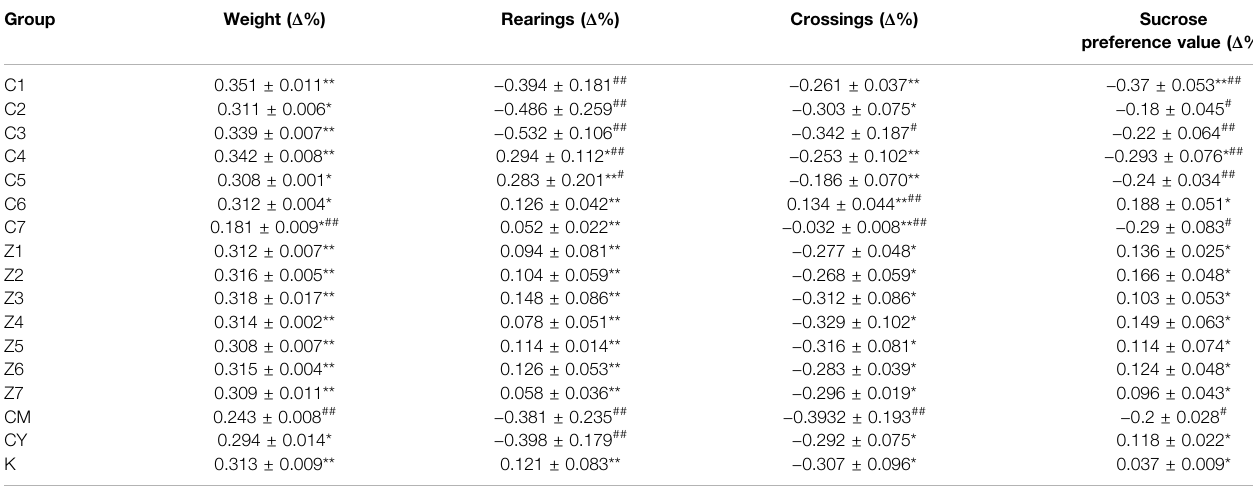
TABLE 2 | Behavior on CUMS and healthy rats administration with PBR (Mean ± SD, n (cid:1) 8). Group Weight ( Δ %)